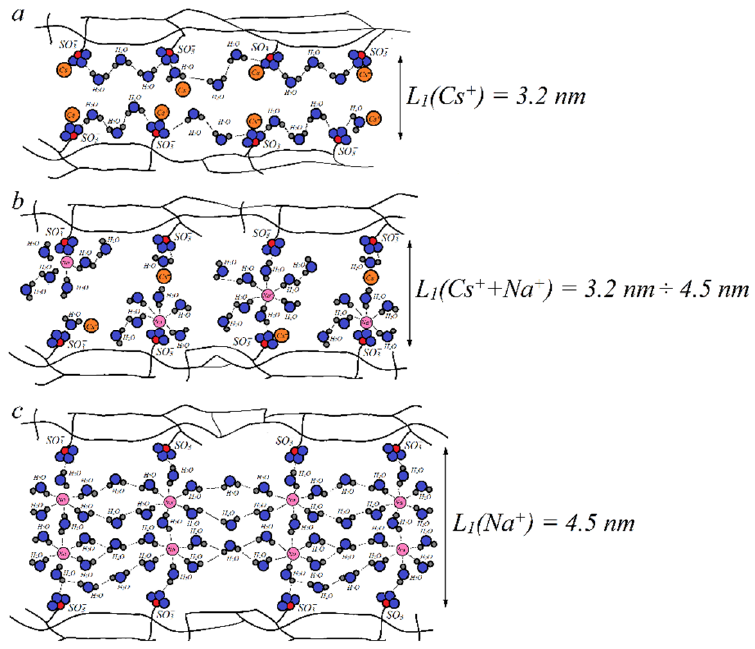
Figure 14. Schematic representation of the Nafion membrane ionogenic channel fragment. Membrane ionic form: ( a ) Cs + , ( b ) mixture Cs + /Na + , ( c ) Na + , where is a SO 3 − group, is a water molecule, is a Na + cation, is a Cs + cation, and L 1 is the channel width [105].